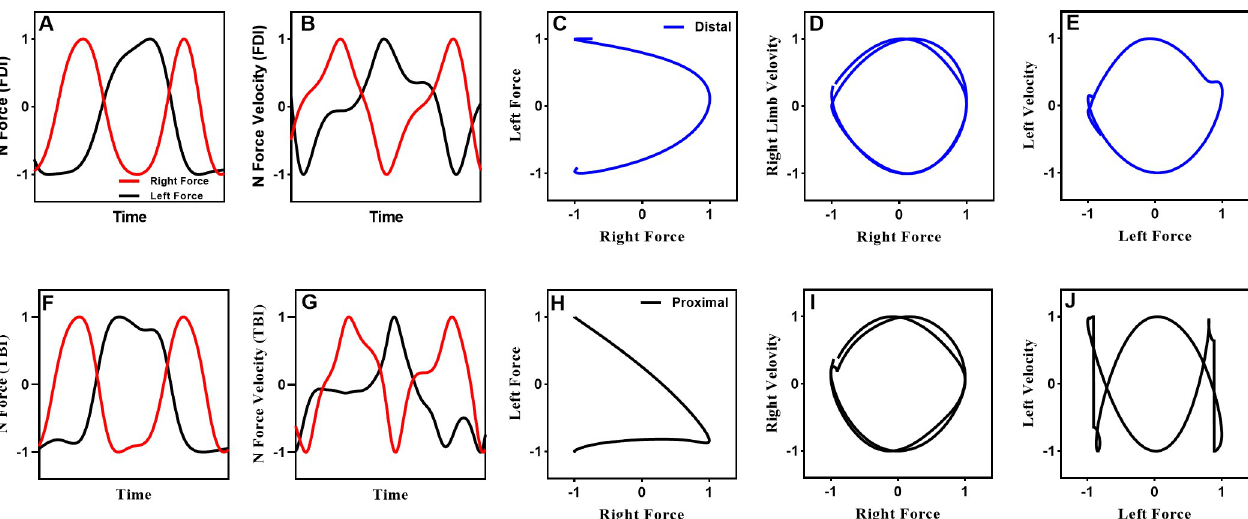
Fig 3. Example performance. (a—e) Example of one cycle of the 1:2 multifrequency task performed with distal effectors and (f—j) one cycle of the task performed with proximal effectors. The figure includes (a, f) non-dominant and dominant effector forces time series, (b, g) non-dominant and dominant effector force velocity time series, (c, h) force-force plots, (d, i) force-force velocity for dominant effector, and (e, j) force-force velocity for non-dominant effector.